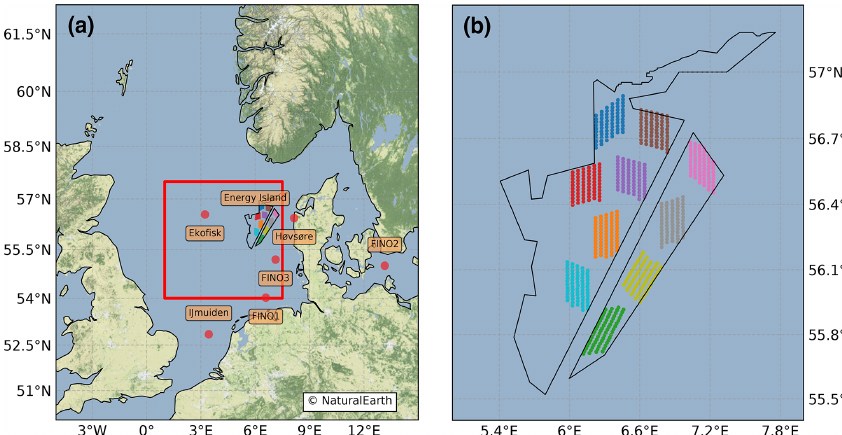
Figure 1. (a) Location of the sites used for validation (red markers) and the area used for spatial averaging (red box). The area in black represents the layout of the Energy Island wind farm cluster. (b) Layout of the future Energy Island wind farm cluster area (black lines) and the 10 wind farms in markers with different